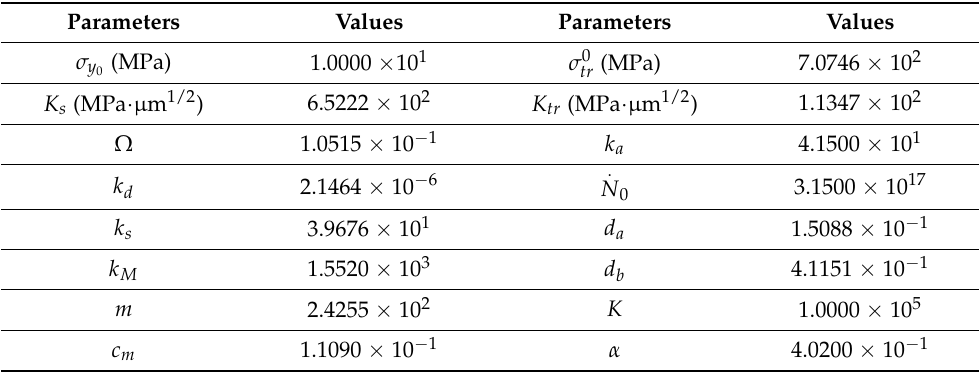
Table 1. Identified parameters of 316L SS constitutive